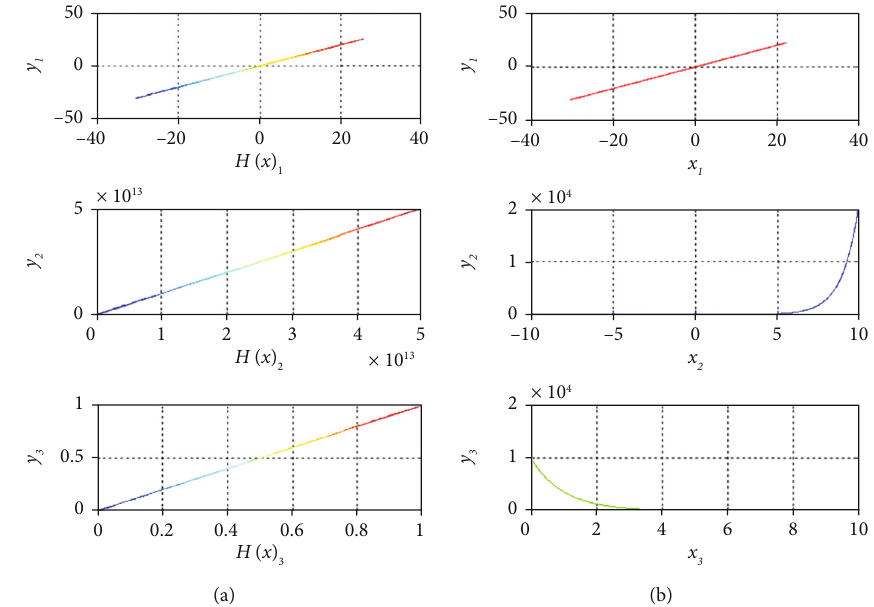
Figure 7: The synchronization relationships of di ff erent state variables in the unidirectionally coupled Chen system. (a) H ð x Þ = ð H ð x Þ Þ T and y = ð y , H ð x Þ , H ð x Þ 1 2 3 synchronization with respect to the exponential manifold y = ½ x